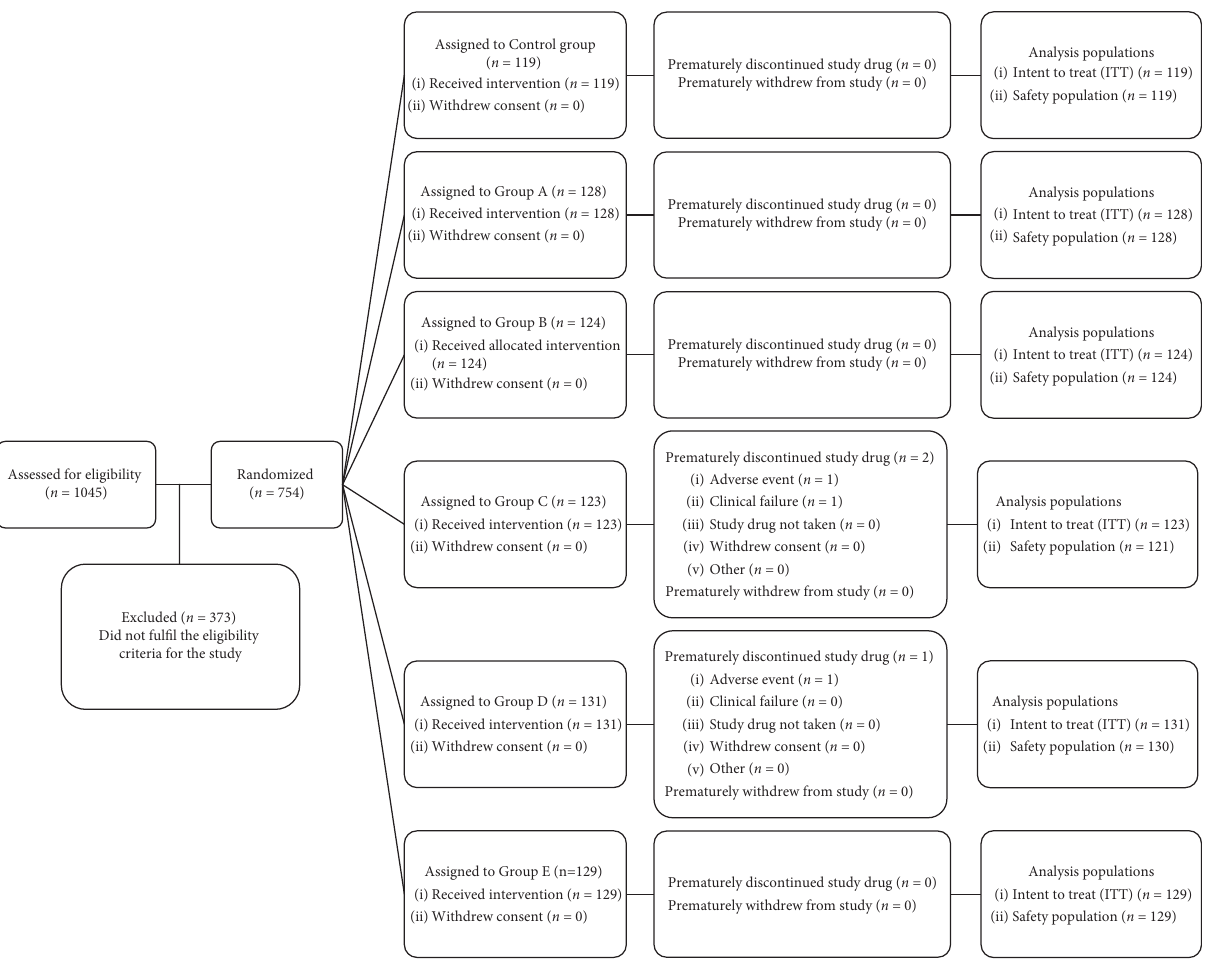
Figure 1: Patients’ clinical study disposition algorithm for comparing the efficacy of lopinavir/ritonavir and azithromycin, lopinavir/ ritonavir and doxycycline, and hydroxychloroquine and azithromycin drug combinations in improving clinical outcomes of COVID-19 patients hospitalized with mild and moderate symptoms. Control group: 1 × 500mg azithromycin per day; Group A: 2 × 200/50 mg lopinavir/ritonavir+1 × 500mg azithromycin per day; Group B: 2 × 200/50mg lopinavir/ritonavir+2 × 100mg doxycycline per day; Group C: 2 × 100 mg hydroxychloroquine +1 × 500mg azithromycin per day; Group D: 2 × 400/100 mg lopinavir/ritonavir+1 × 500mg azithromycin per day; Group E: 2 × 400/100mg lopinavir/ritonavir+ 2 × 100mg doxycycline per